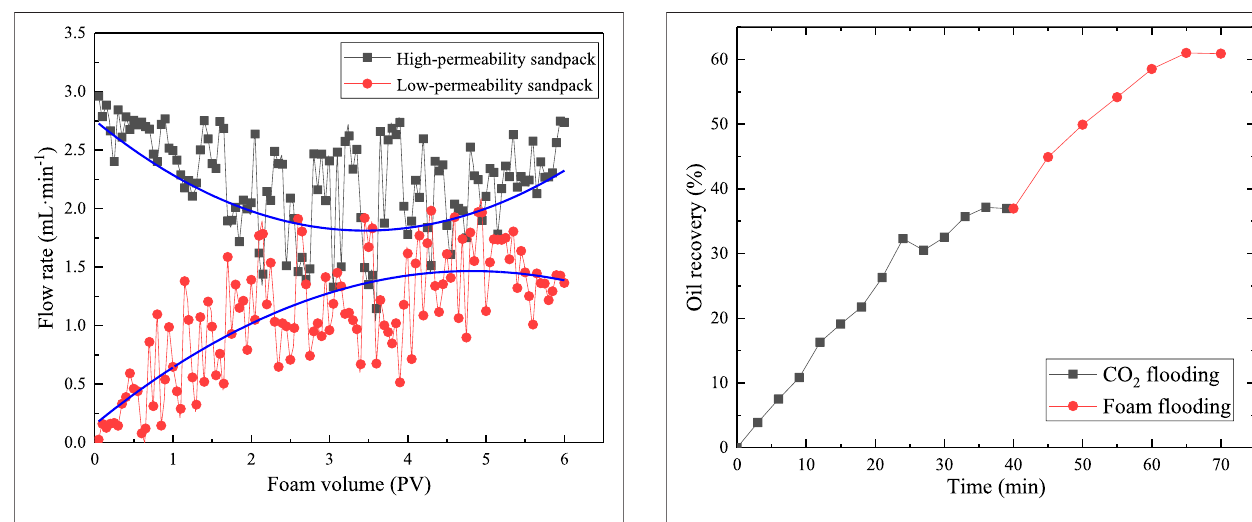
FIGURE11| Recoveryofgascapdriveandfoam fl ooding (Temperature was 90 ° C, CO 2 fl ooding injection rate was 3 ml min − 1 , foam injection rate was 5 ml min − 1